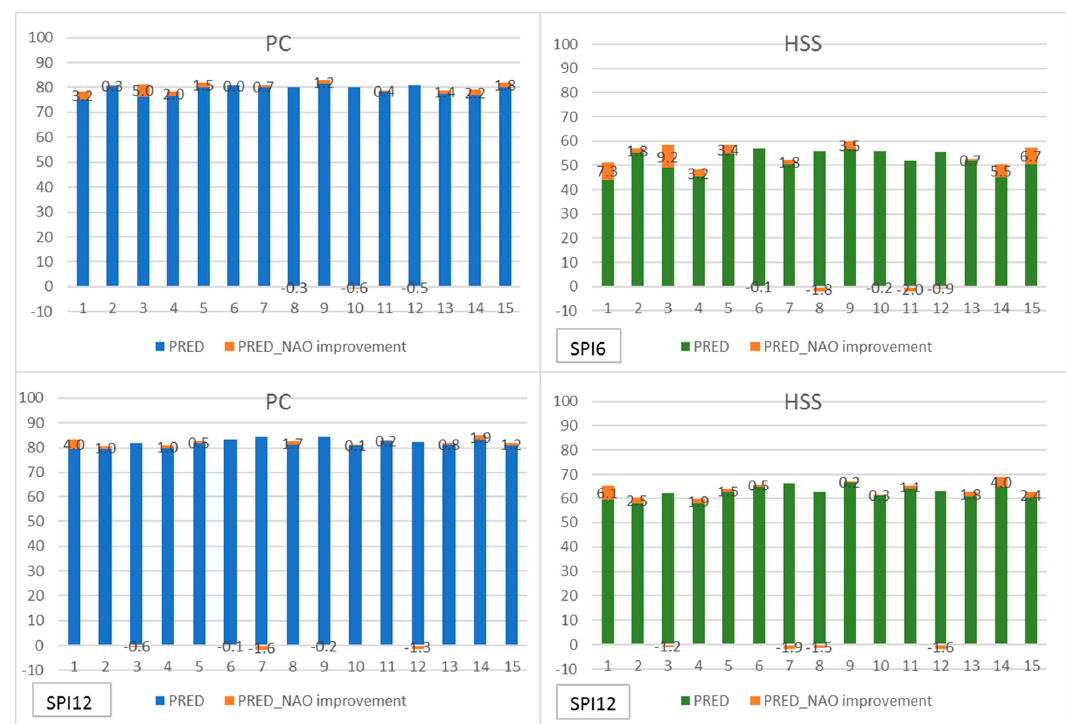
Figure 7. PC and HSS improvement (%) considering the influence of NAO on the SPEI6 and SPEI12 modeling for all months for each of the 15 grid points.